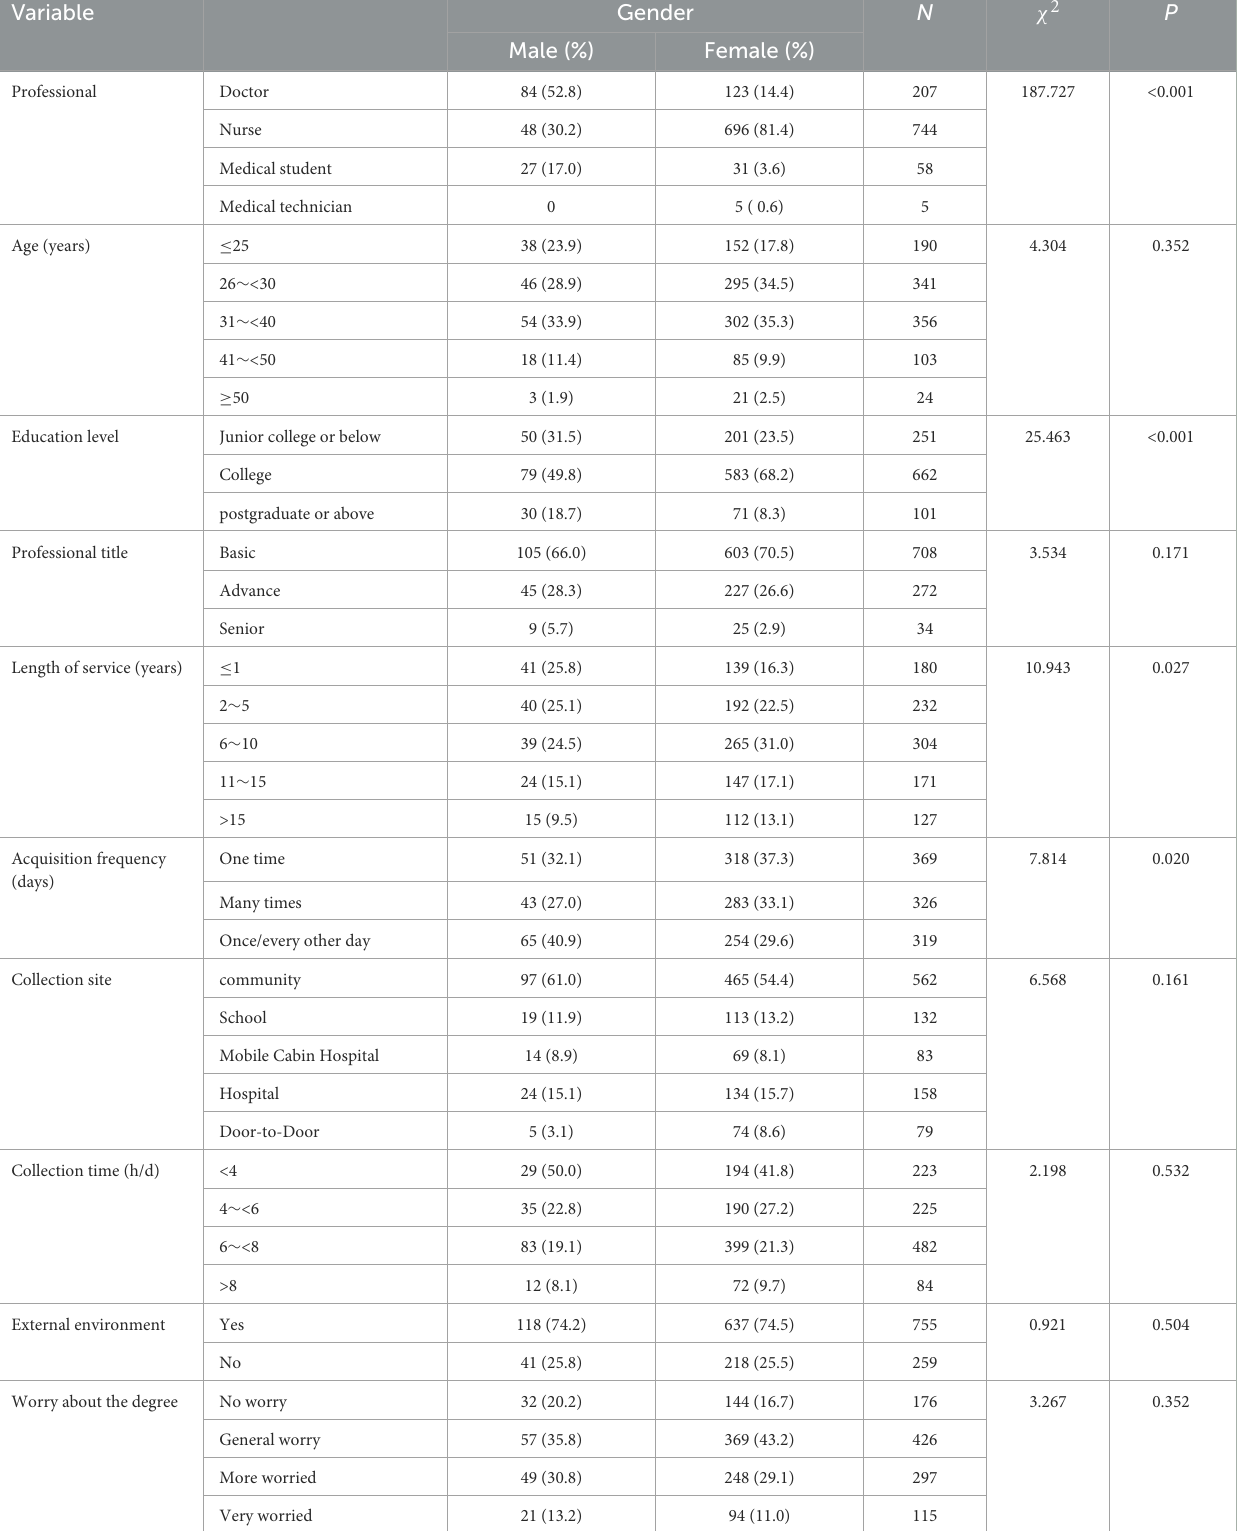
TABLE 1 Demographic characteristics of study sample [ N =